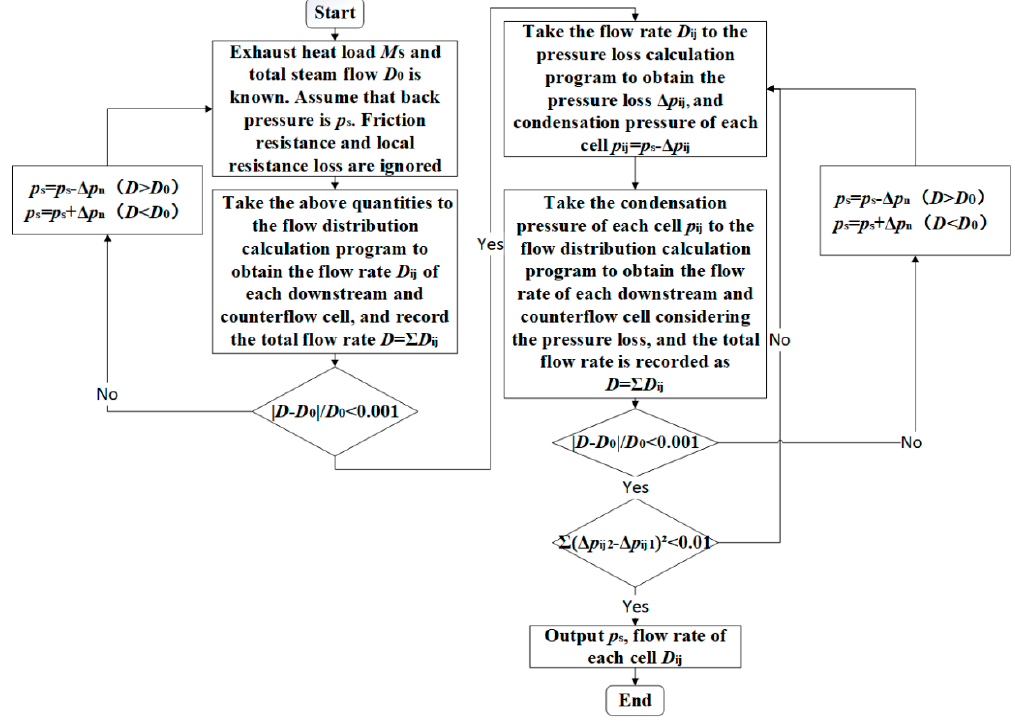
Figure 4. Flow chart of the coupled calculation program.